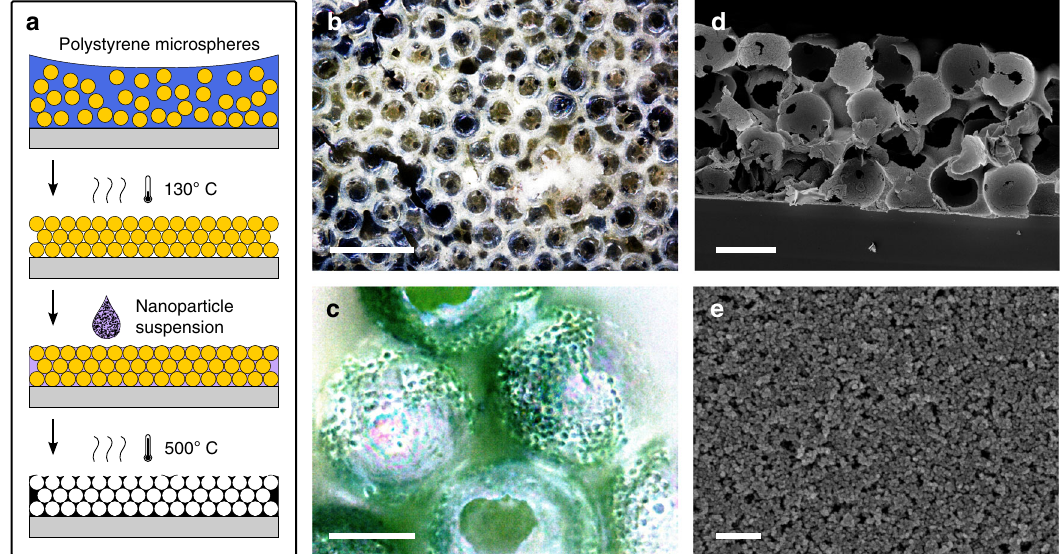
Fig. 2 Electrode porosity. a Scheme of microporous electrode fabrication method. b Optical bright fi eld microscopy image of an empty microporous electrode (scale bar: 100 µ m). c Optical dark fi eld microscopy image showing an electrode fi lled with cyanobacteria (after rinsing with water; scale bar: 20 µ m). Scanning electron microscopy (SEM) images showing d the cross-section of the electrode (scale bar: 40 µ m) and e the nanoporous structure of sintered nanoparticles (scale bar: 400